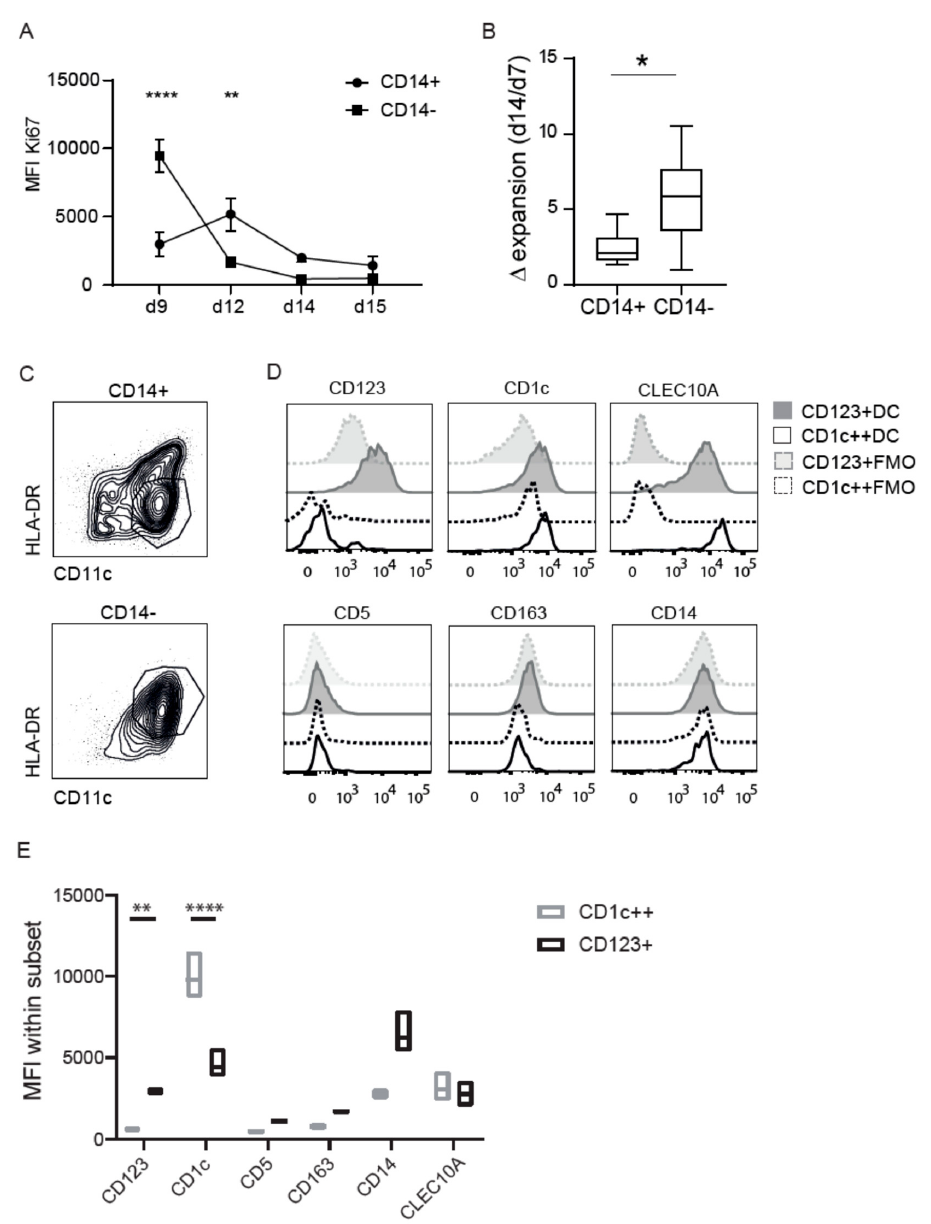
Figure 2. Proliferation, expansion, and differentiation. ( A ) Ki67 staining overtime in CD14 − or CD14+ sorted populations in differentiation to DC in the presence of GM-CSF, IL-4, SCF, and FLt3L (d8-d14) or after maturation with PGE2, TNF-alfa, IL-6, and IL-1b in combination with the aforementioned differentiation mix (d15). The experiment was repeated 3 times; the two-way ANOVA test was used to test significance **** = p < 0.0001 and ** = p < 0.01. ( B ) Delta expansion calculated with the total differentiated cells after differentiation (day 14) divided by the sorted precursors at day 7 of expansion. Different experiments were performed with a total of eight donors. The Wilcoxon rank test was used to test significance * = p < 0.05. ( C ) HLA-DR and CD11c expression by differentiated CD14 − or CD14+ precursors. ( D ) Flow cytometric analysis of DC markers expressed by CD1c++DCs (black), CD1c++DC FMO (black dashed), CD123+DCs (grey), and CD123+DC FMO (light grey) in histogram and ( E ) MFI in boxplot of three different donors. The populations were pre-gated on live cells based on SSC/FSC, followed by HLA-DR and CD11c shown in A. The plots represent the mean with SD. The dots represent individual data; the two-way ANOVA test was used to test significance between CD1c++DC and CD123+DC ** = p < 0.01, **** = p <